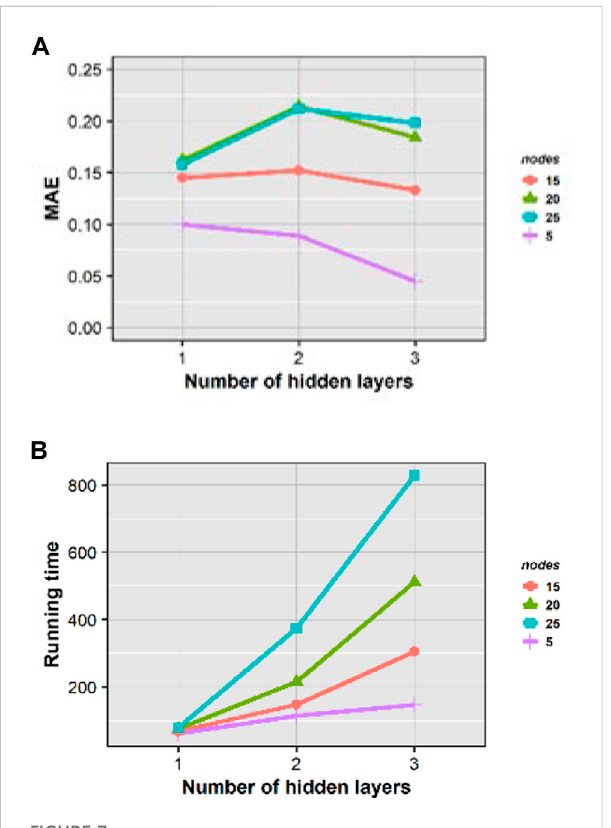
FIGURE 7 MAE values under different hidden layer parameters.